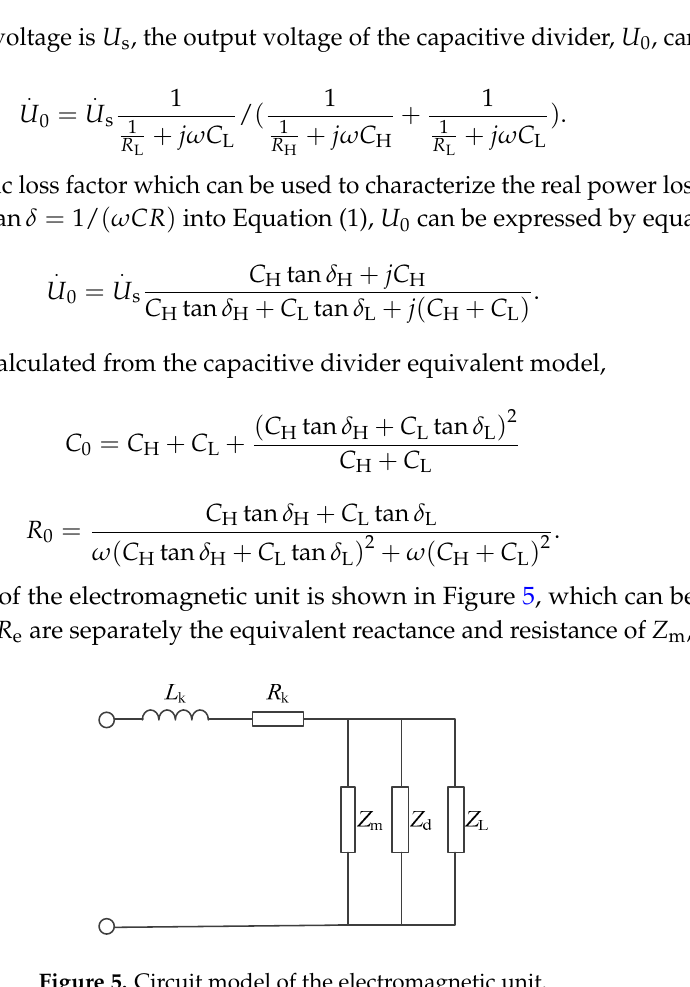
Figure 4. Thevenin model of the capacitive divider.